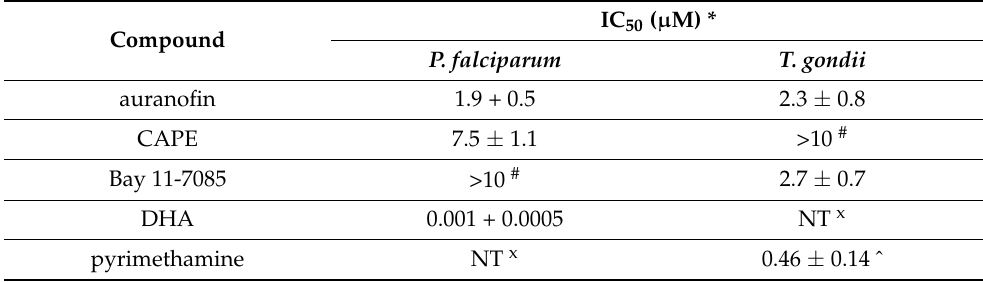
Figure 4. Bay 11-7085 and auranofin appear to bind directly to IMP α s as indicated by thermostability analysis. The indicated His6-tagged IMP α proteins were subjected to thermostability analysis in the presence of increasing concentrations in the indicated compounds. Results are from a single experiment, representative of three independent experiments. Table 3. Summary of the IC 50 values for inhibition of P. falciparum and T. gondii parasites by IMP α inhibitors in